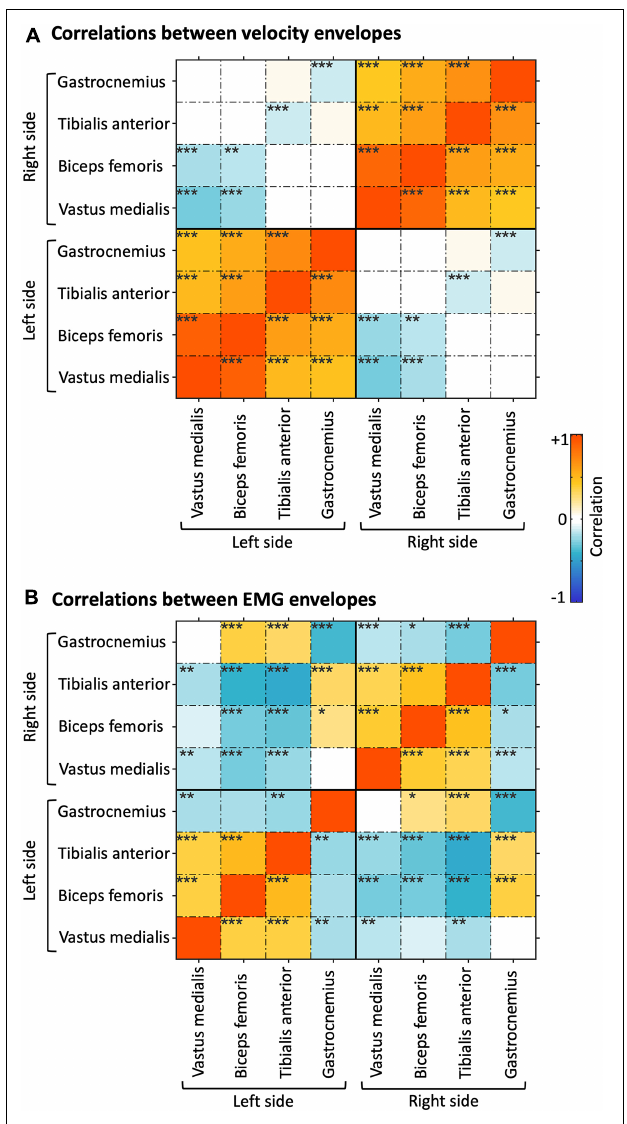
FIGURE 4 | Correlation analysis of velocity and EMG envelopes. (A) Correlations of velocity envelopes across body sensors. (B) Correlations of EMG envelopes across body sensors. The results presented refer to the average across participants. *p FDR < 0.05; **p FDR < 0.01; ***p FDR < 0.001.